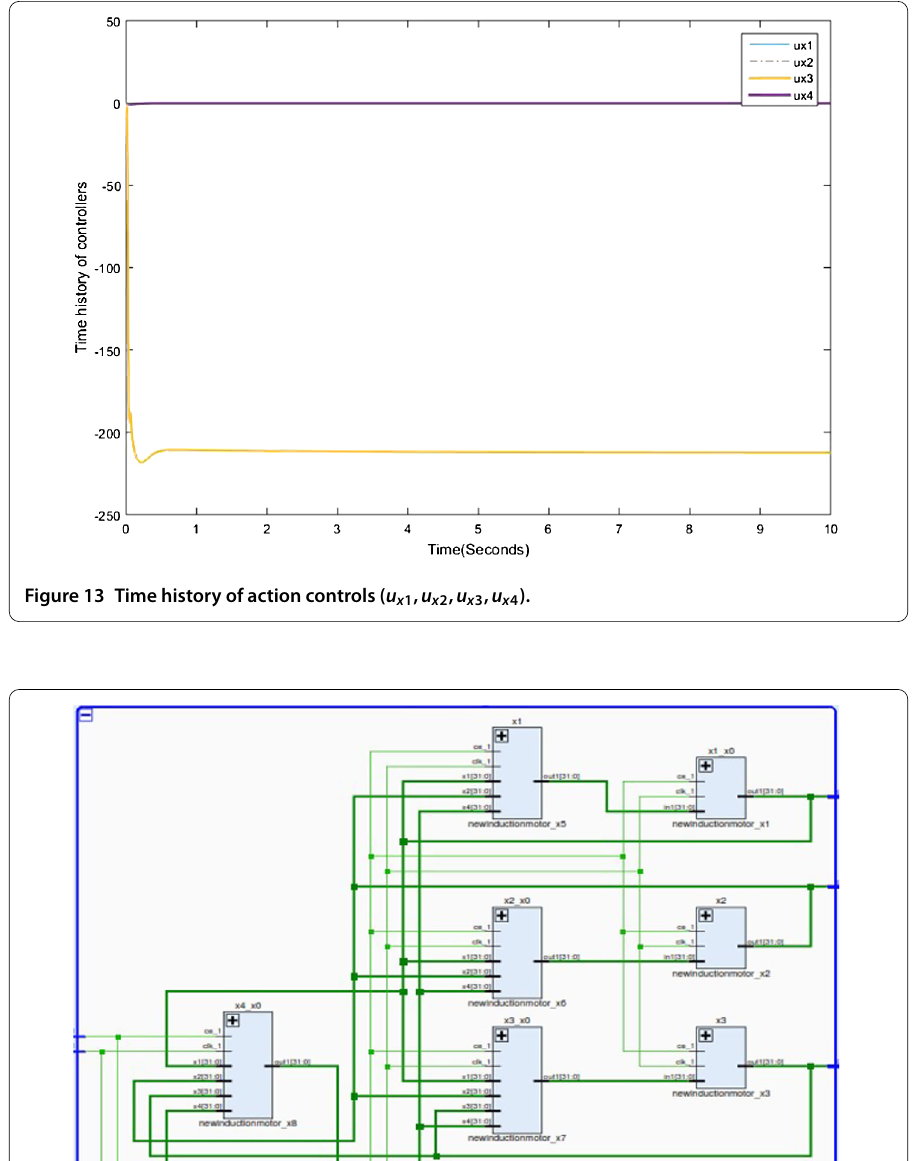
shows the Xilinx RTL schematics of the FOIM system implemented in Kintex (Device = kt, Package = fbg S), and Figure shows the Xilinx RTL Kintex schematics of the FOASMC with fractional-order integrators. Figure shows the parameter update laws for estimating the unknown load. Figure shows the RTL shematics of sliding sur- faces with the sliding reaching laws. Figure shows the controlled states of the FOIM system using FOASMC controllers implemented using Xilinx System